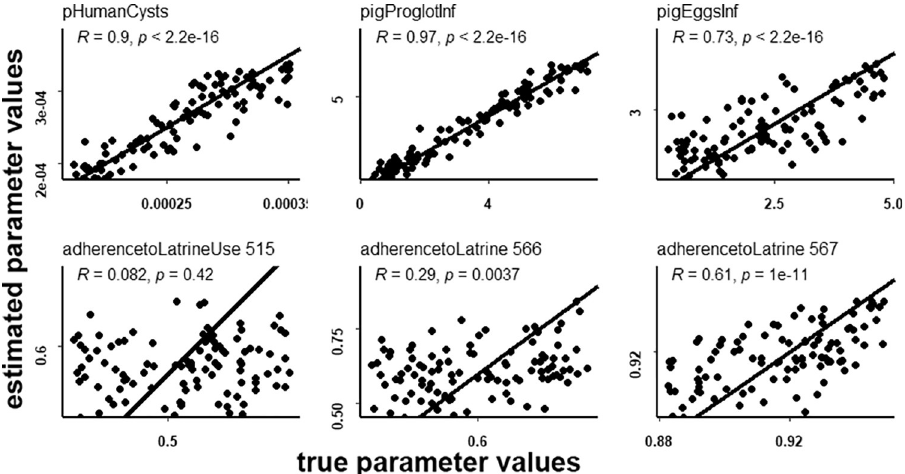
Fig 6. Cross-validation noNecro setup. Cross-validation for 100 randomly selected simulations from the noNecro calibration setup, third stage. Estimated parameter values are compared to true values for the 6 calibration parameters with the identity line plotted as reference. The correlation coefficient between estimated and true parameter values is shown for each parameter together with the corresponding p value.